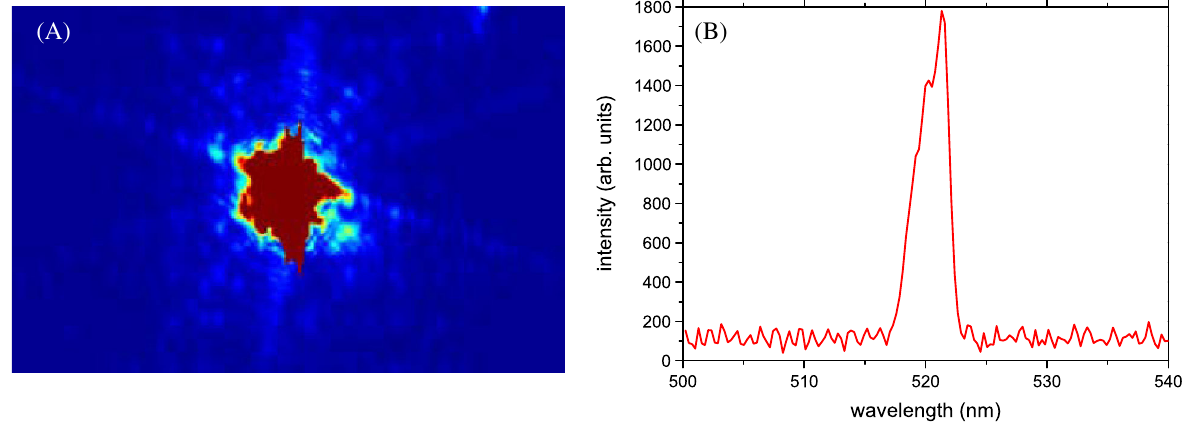
FIG. 7. (A) Radiation intensity on an OTR screen downstream of the radiator, the radiation was recorded by a CCD with a 400–800 nm bandpass filter. (B) Single shot second harmonic CHG spectrum detected by a miniature fiber-optic spectrometer.